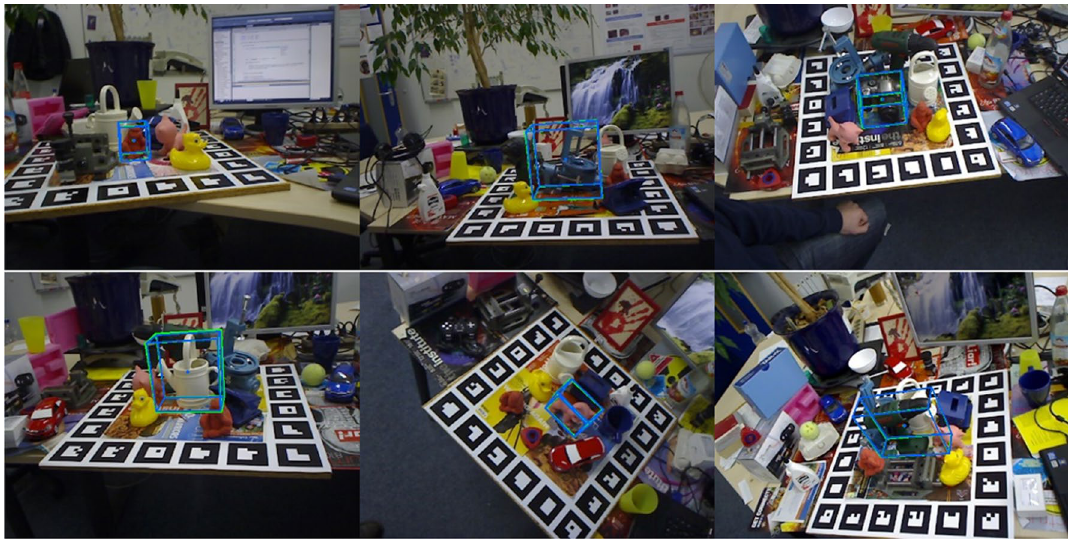
Figure 3. Single object detection map (green is ground truth, blue is predict. The first column is object id: 1 2 4, and the second column is object id: 5 6 8).